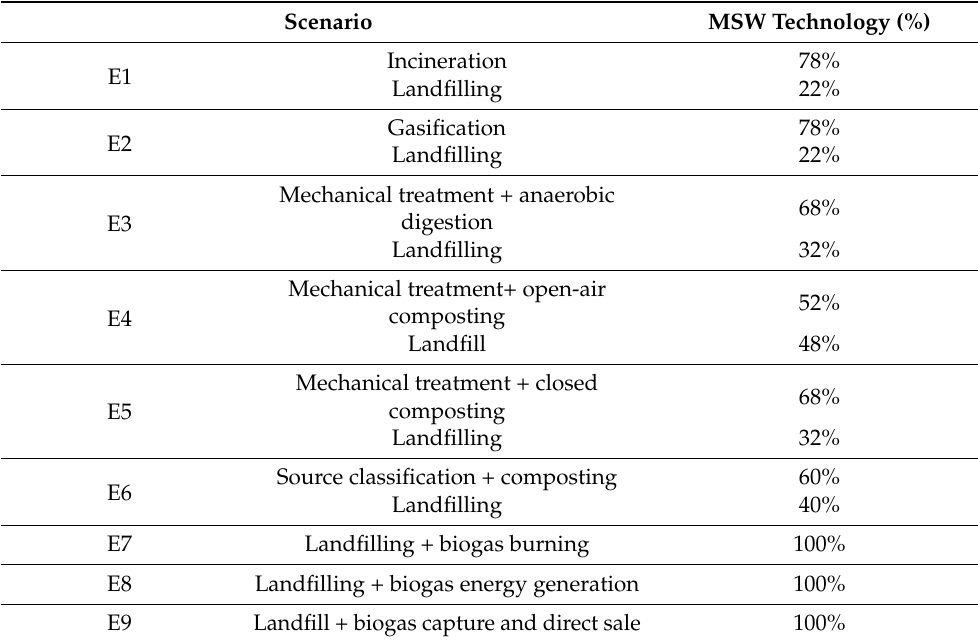
Table 2. Proposed scenarios as defined by the Inter-American Development Bank study